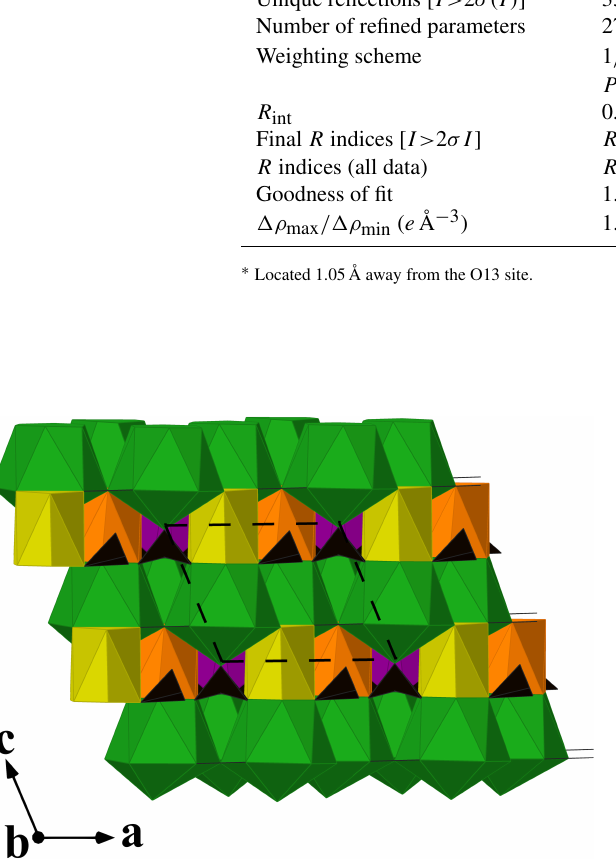
Figure 4. A view along [010] of the crystal structure of donnayite- (Y). Sr-, Na-, Ca-, and Y-centred polyhedra are shown in green, yellow, orange, and purple, respectively. Carbonate groups are black triangles. The unit cell is